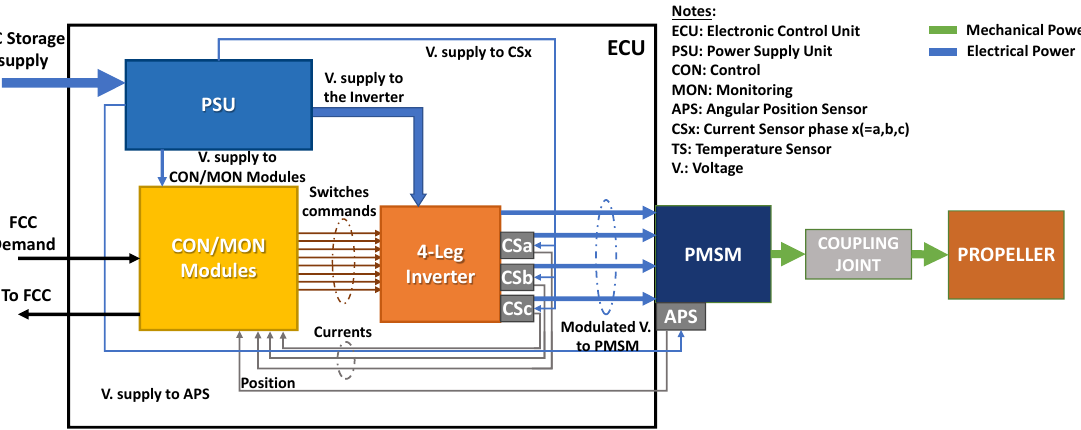
Figure 2. Schematics of the UAV propulsion system architecture.